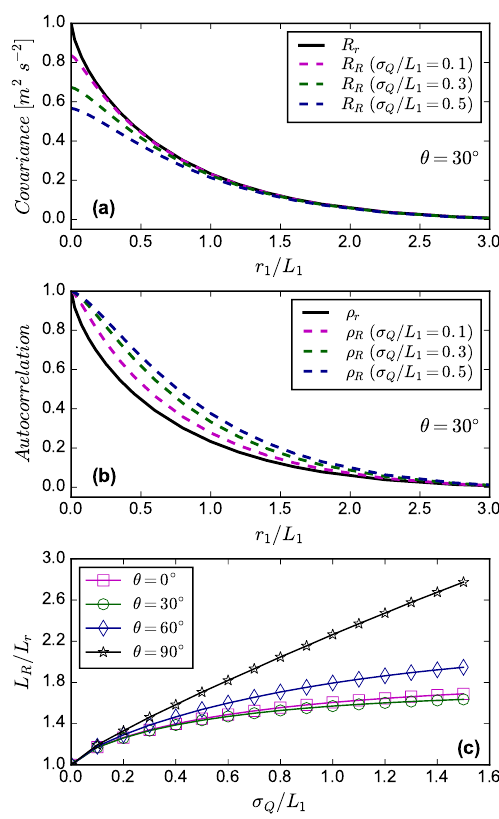
Figure 2. Examples of turbulence statistics of point radial veloc- ity ( v r ) and averaged radial velocity ( v R ) derived from Eqs. (6) and (7) using the isotropic turbulence model (Pope, 2000) and the von Kármán spectra (Burton et al., 2011) with streamwise velocity U 1 = 8ms − 1 , turbulence intensity = 12.5%, and lidar elevation an- gle = 10 ◦ . The covariance and autocorrelation functions for v r ( R r and ρ r ) and v R ( R R and ρ R ) for azimuth angle θ = 30 ◦ are shown in (a) and (b) , respectively, as functions of r 1 /L 1 , where r 1 is the spatial lag in streamwise direction and L 1 is the integral length scale of streamwise velocity. R R and ρ R are presented in terms of σ Q /L 1 , where σ Q represents the size of volumetric averaging (see Eq. 5). The effect of volumetric averaging on the integral length scale of radial velocity is presented in (c) in terms of the relationship be- tween L R /L r and σ Q /L 1 for different θ values, where L r and L R are the integral length scales for v r and v R ,